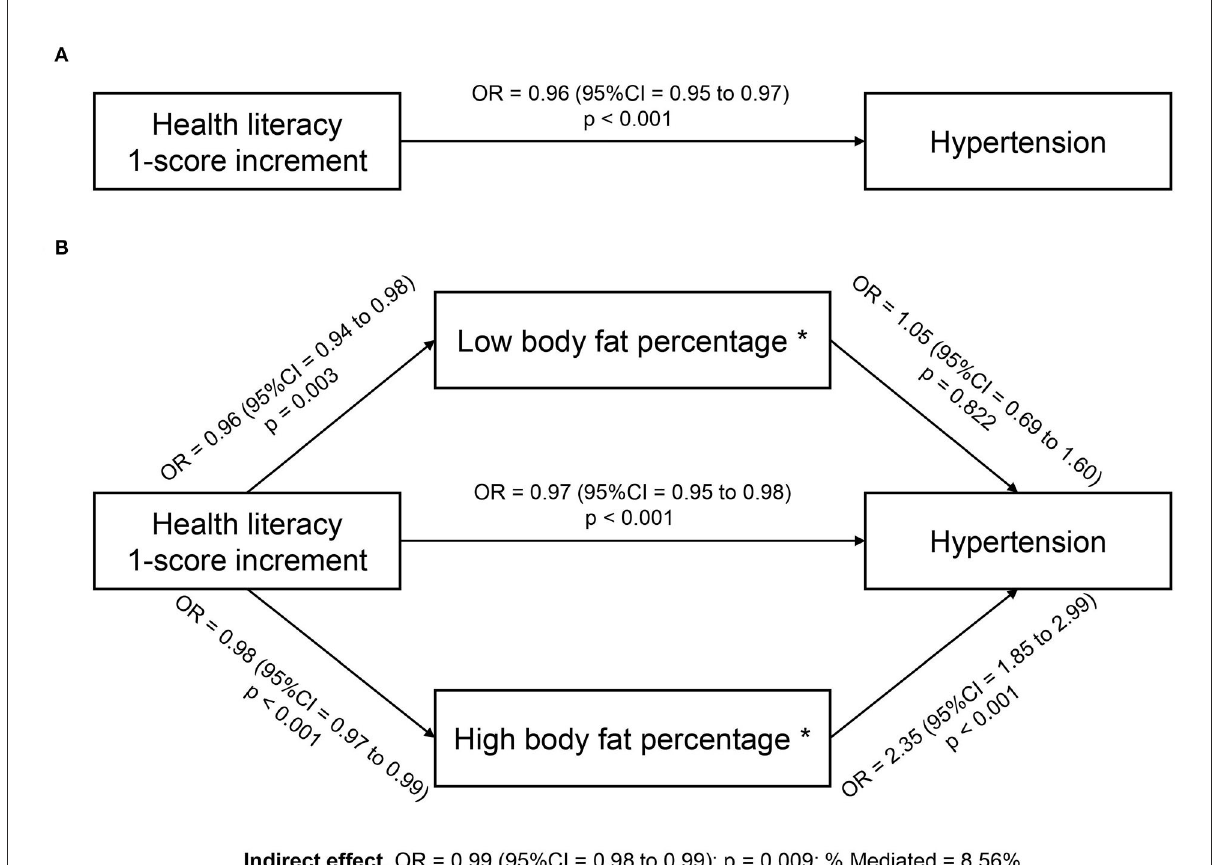
FIGURE1 Body fat percentage mediates the association between health literacy and hypertension among rural people ( n = 1,655). *The reference group is normal body fat percentage. (A) Total effect; (B) Direct and indirect effects. Mediation models were adjusted for age, gender, education, social status, medical conditions, physical activity, and healthy eating